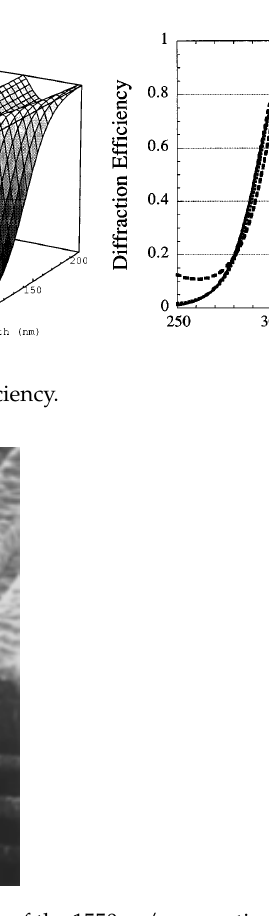
Figure 6. Cross ‐ sectional SEM image of the 1550 gr/mm grating. Figure 6. Cross-sectional SEM image of the 1550 gr/mm